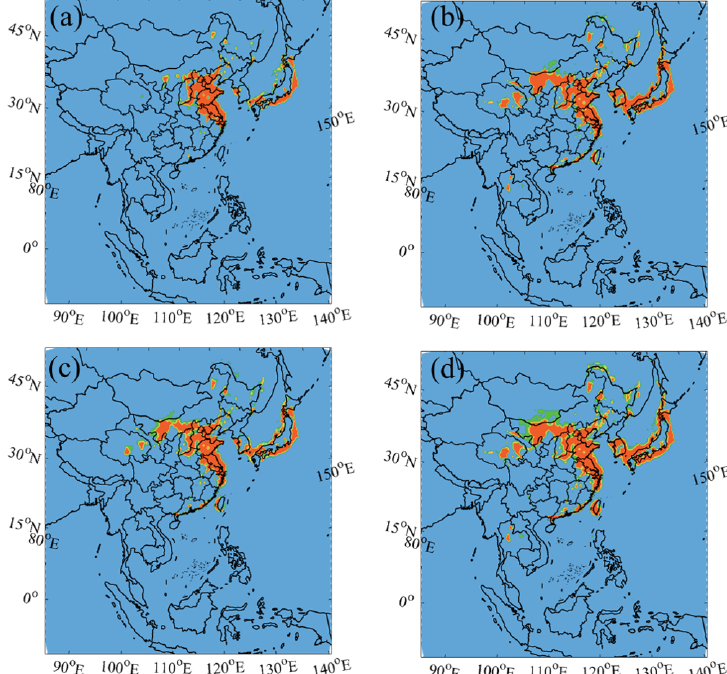
Figure 7. The O 3 sensitivity regimes using the (a) Def, (b) HONO, (c) Cl, and (d) the BASE cases. The classification of the ozone sensitivity regime is based on production rates of H 2 O 2 to HNO 3 , and P H transition, and NO x -limited conditions respectively (Zhang et al.,